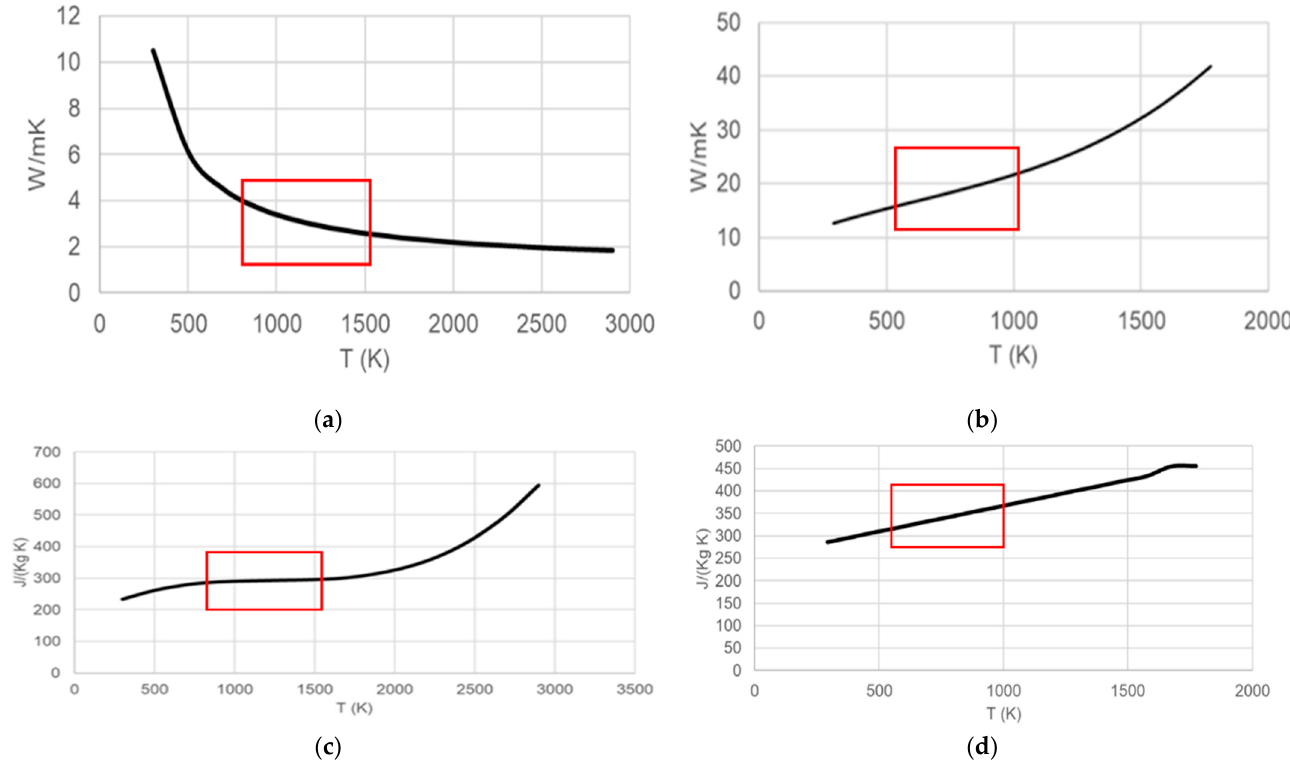
Figure 21. Effect of the codes (APOLLO3 ® /THEDI and ATHENA) used. Power ( a ); reactivity ( b ).